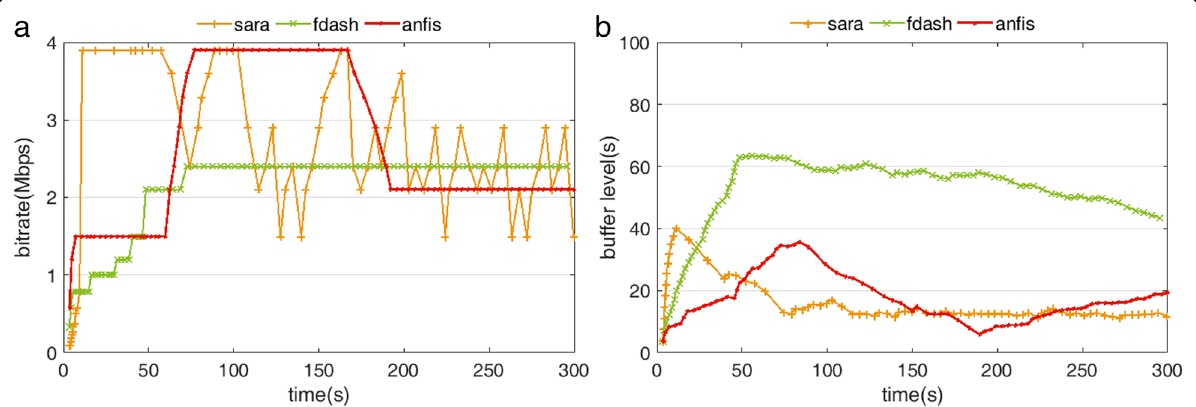
Fig. 8 Simulation results in first LTE environment. a The segment bit rate requested by client over time. b The client ’ s playback buffer level